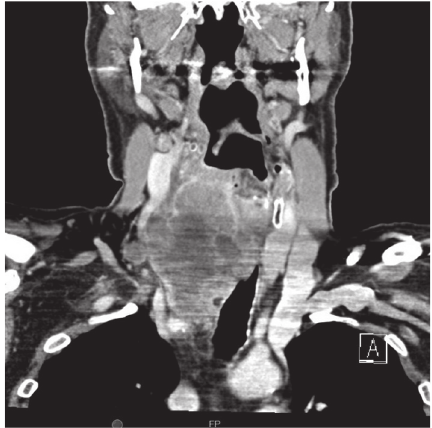
Figure 2: CT scan of the neck at presentation (coronal image).